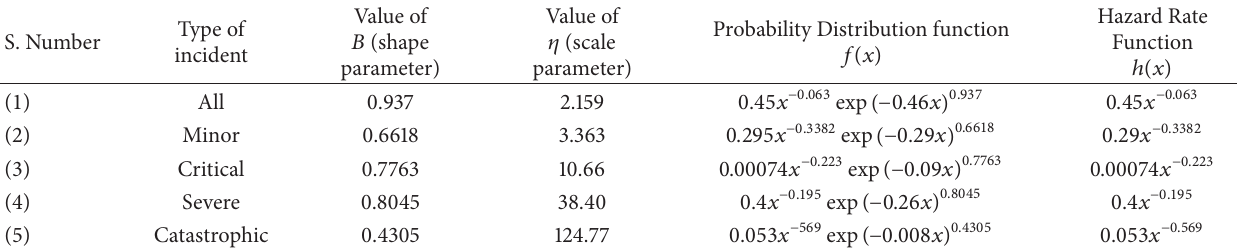
Table 2: Output of Weibull analysis as probability distribution function and Hazard Rate Function. S.